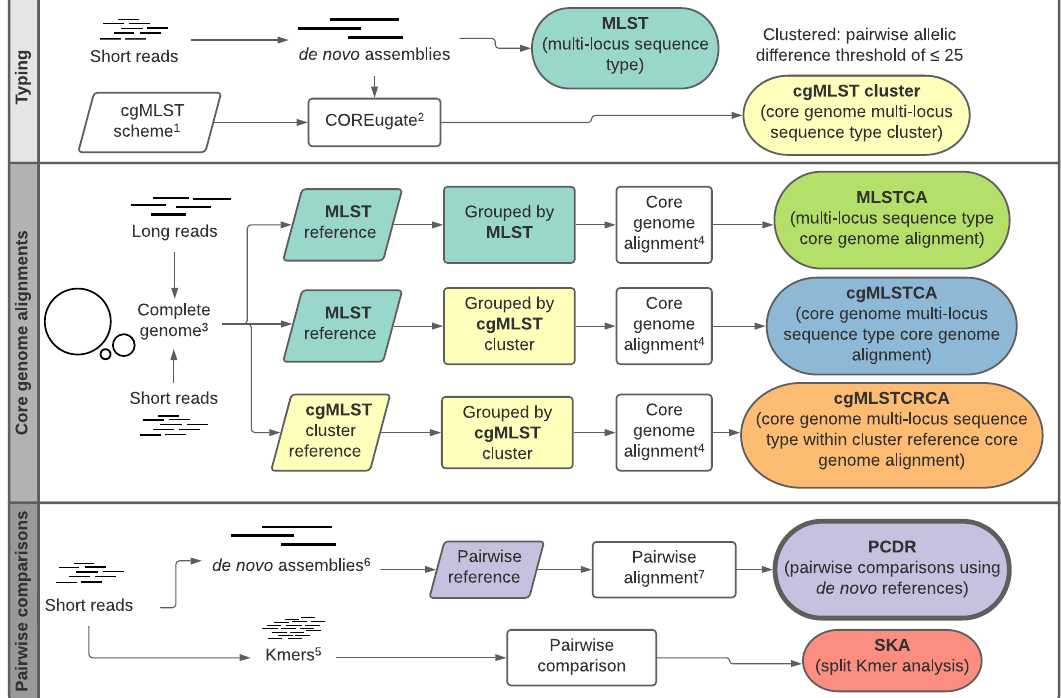
Fig. 6 Methods for investigating the genomic diversity of vancomycin-resistant E. faecium . This fl ow chart provides an overview of all the genetic comparison approaches used in the study. It has been split into three sections based on the type of analysis that each approach uses: typing, core genome alignments and pairwise comparisons. Pairwise comparison using de novo references (PCDR) was used as the gold standard method for determining genomic diversity. 1 core genome multilocus sequence type (cgMLST) allele scheme by de Been et al. 2 The COREugate pipeline was used to assign the allelic pro fi les and build a matrix of the pairwise allelic differences. 3 Complete genomes were assembled using Unicycler/Canu (multilocus sequence type (MLST) references) or Trycycler (cgMLST references). 4 Core genome alignments were performed using short-read data and snippy. Pairwise distances were then generated from the core alignment. 5 Split kmers were generated from short read data at k = 15. 6 de novo assemblies were performed using SKESA. 7 Individual snippy alignments were performed using the de novo assemblies and short read data on each pair. Any self-single nucleotide polymorphisms identi fi ed from mapping self reads to the de novo assembly were removed. The mean of the two reciprocal alignments was then used as the pairwise